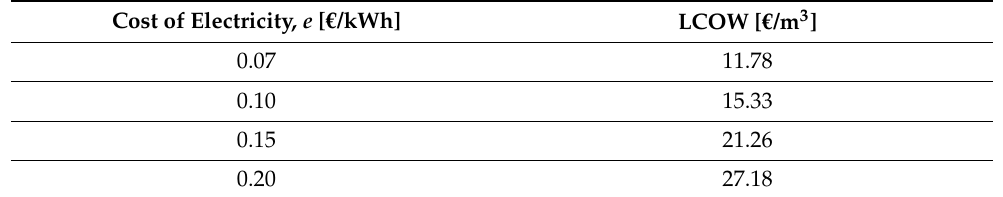
Table 4. Estimation of